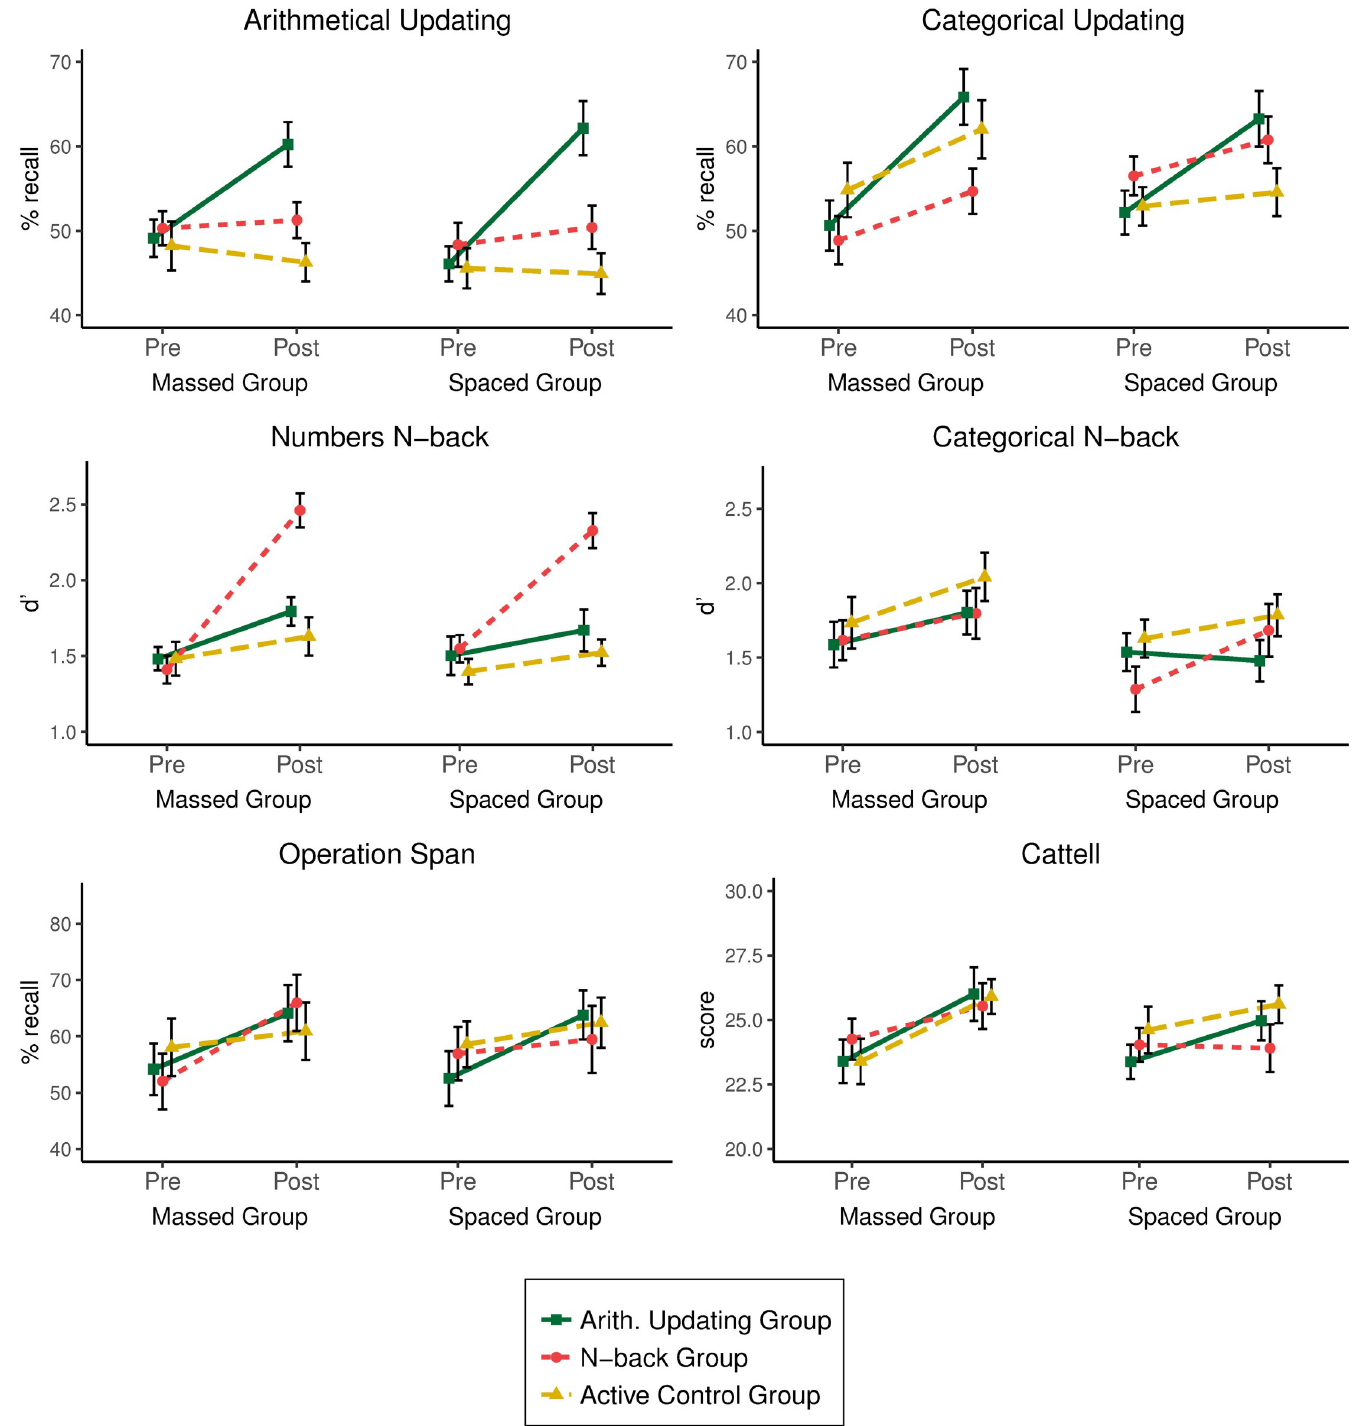
Fig 3. Scores obtained in all transfer tasks by group (arithmetical, n -back, active control) and practice distribution (massed, spaced).